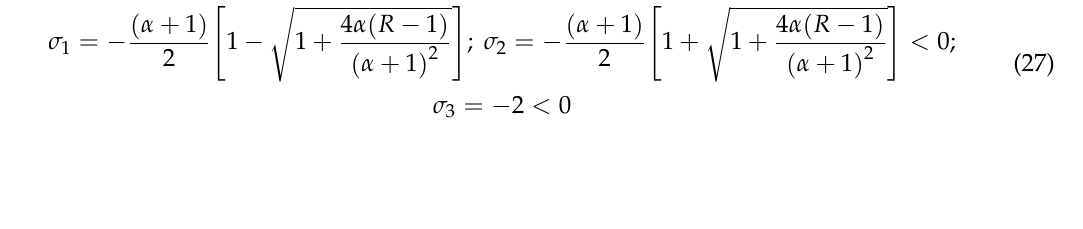
Figure 2. Graphical description of the solutions ( a ) A 11 ; ( b ) B 11 ; and ( c ) B 02 , as a function of R on bifurcation diagrams [21]. (Reproduced with permission from Peter Vadasz, Journal of Porous Media; published by Begell House,